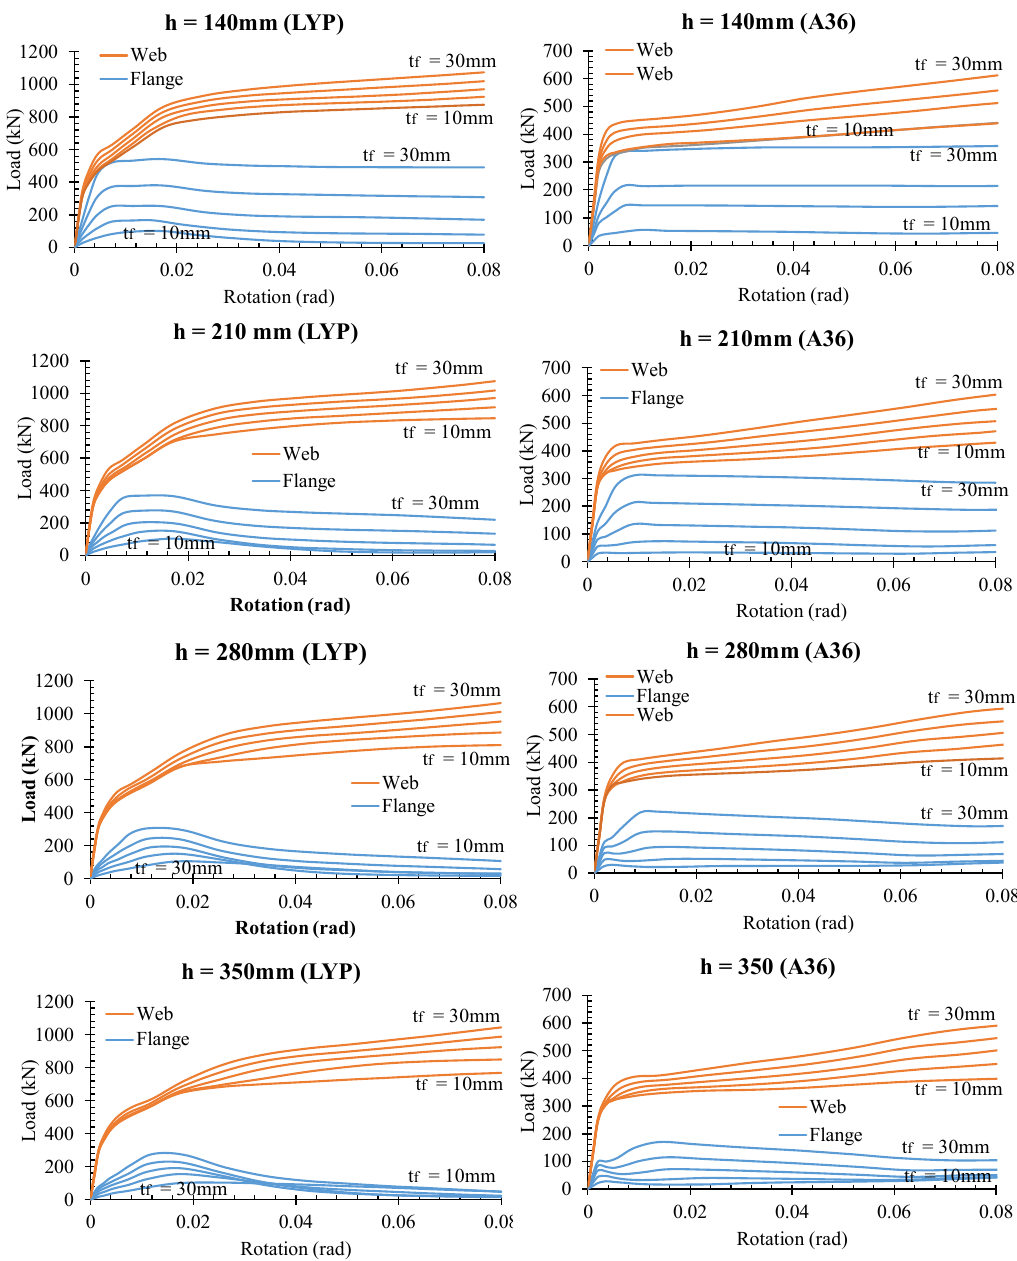
Figure 9. Contribution of the flange to the damper shear strength.